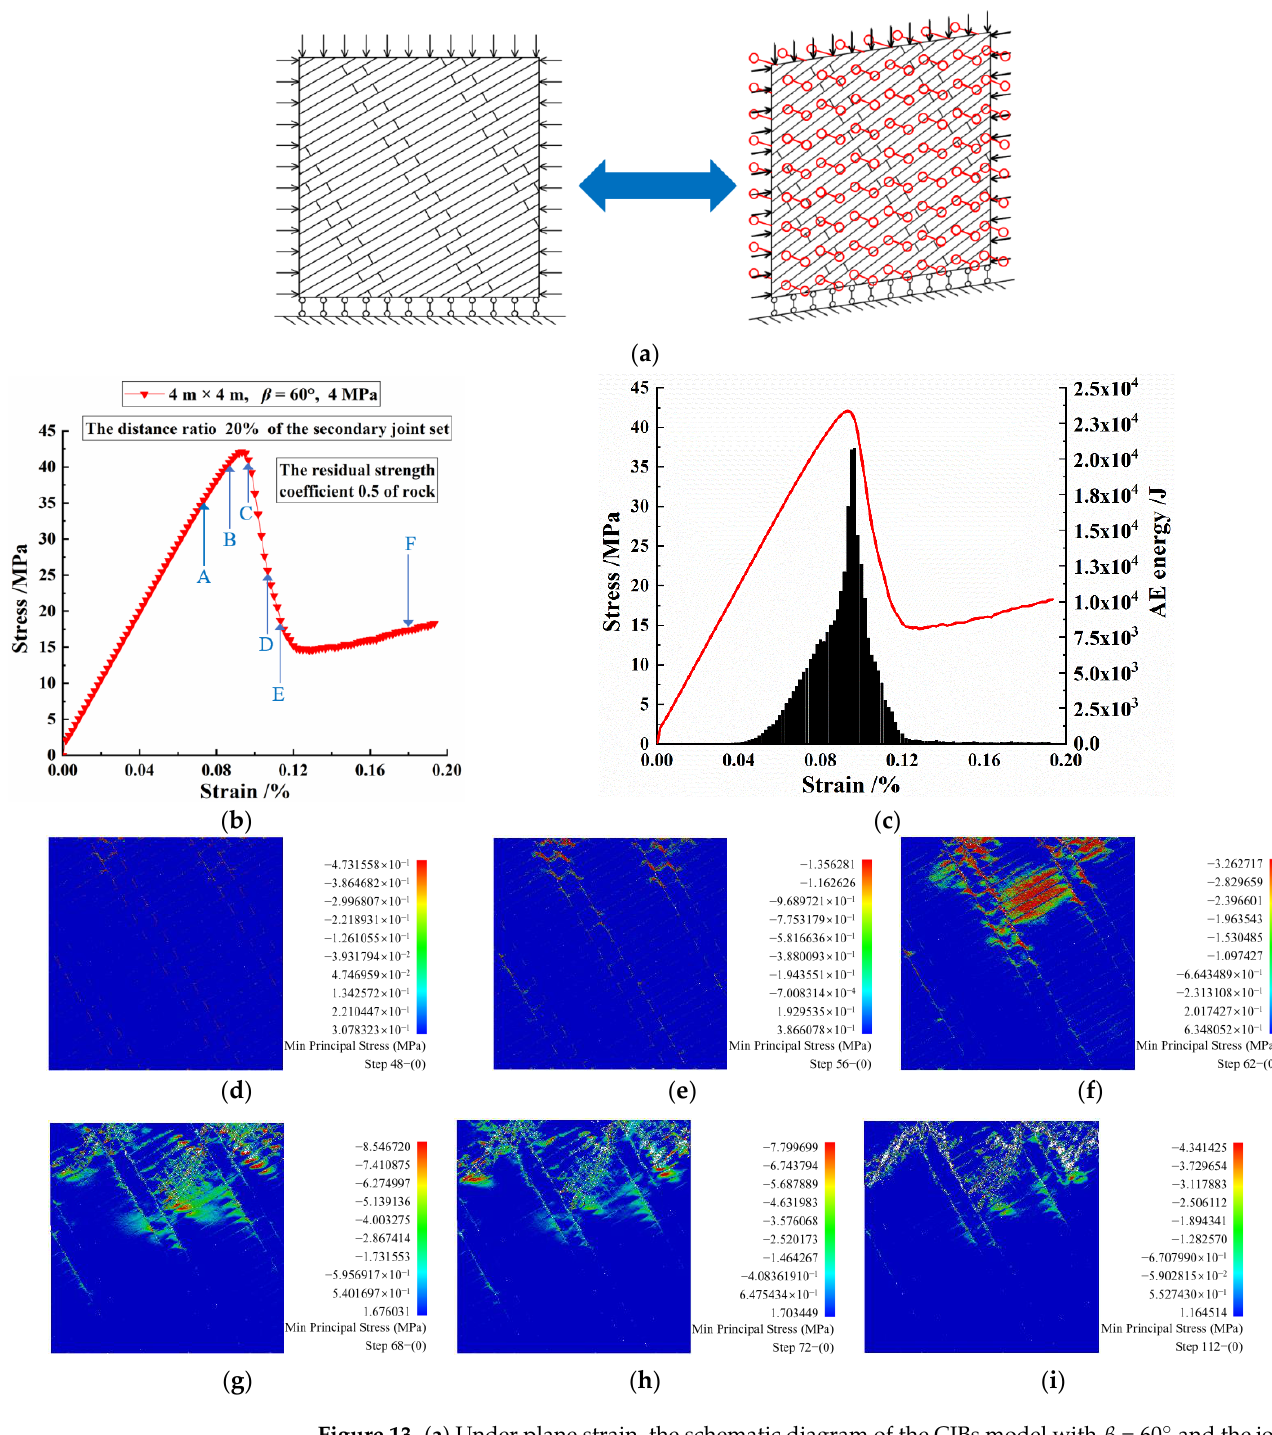
Figure 13. ( a ) Under plane strain, the schematic diagram of the CJBs model with β = 60° and the joint distance ratio 20%; ( b , c ) the loading curve and AE energy; ( d – i ) the minor principal stress contours at the Points A~F.